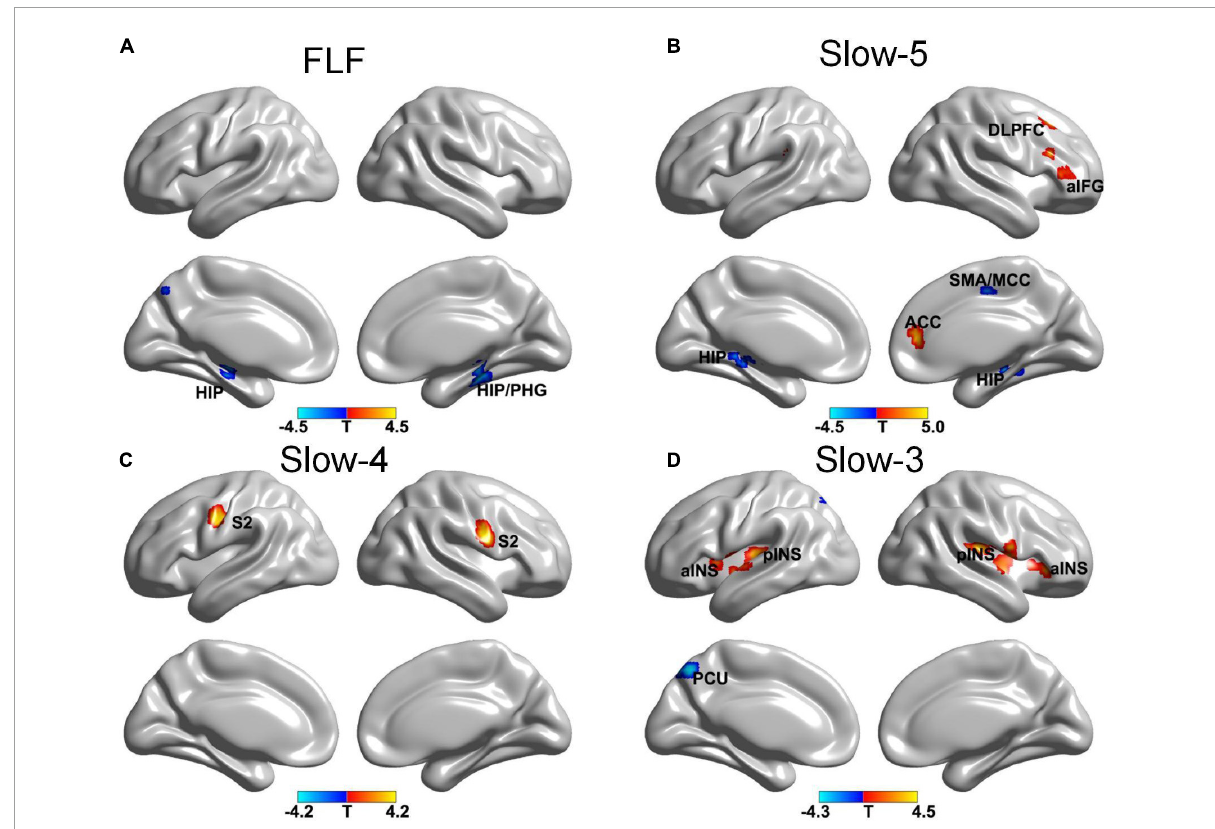
FIGURE1 The gFCD distribution patterns at multiple frequency-bands following verum acupuncture (voxel-level p < 0.005, cluster-level p < 0.05, cluster size > 20 voxels, the small volume corrected and FWE corrected). (A) A decreased gFCD in HIP/PHG at FLF; (B) A decreased gFCD in HIP, MCC/SMA and an increased gFCD in ACC, DLPFC, and aIFG at Slow-5 band; (C) An increased gFCD in S2 at Slow-4 band. (D) A decreased gFCD in the PCU, and an increased gFCD in INS. gFCD, global functional connectivity density; HIP, hippocampus; PHG, parahippocampal gyrus; SMA, supplementary motor area; MCC, middle cingulate cortex; DLPFC, dorsolateral prefrontal cortex; S2, second somatosensory cortex; aINS, anterior INS; pINS, posterior INS; PCU,